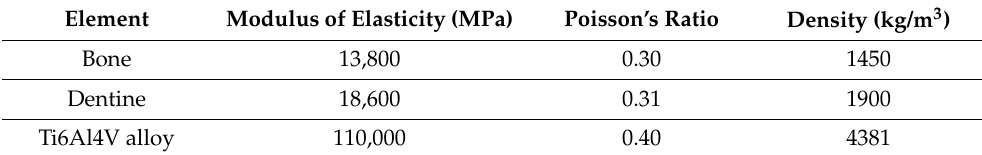
Table 1. Material characteristics for each element of the structure subjected to finite element analysis. Element Modulus of Elasticity (MPa) Poisson’s Ratio Density (kg/m 3 ) Bone 13,800 Dentine 18,600 Ti6Al4V alloy